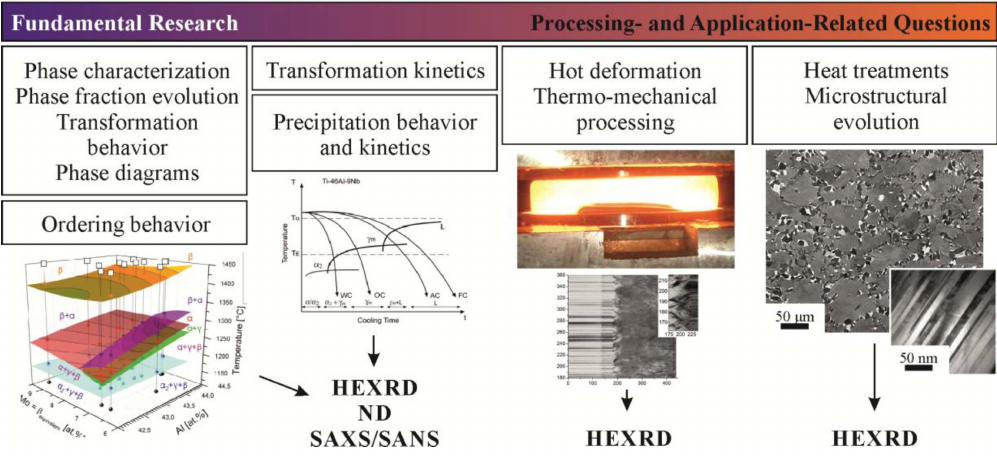
Figure 2. Scheme of the application range of in situ characterization techniques based on synchrotron radiation and neutrons in the development of intermetallic titanium aluminides. Neutron diffraction (ND), high-energy X-ray diffraction (HEXRD), and small-angle scattering methods (small-angle X-ray scattering (SAXS)/small-angle neutron scattering (SANS)) address a wide variety of